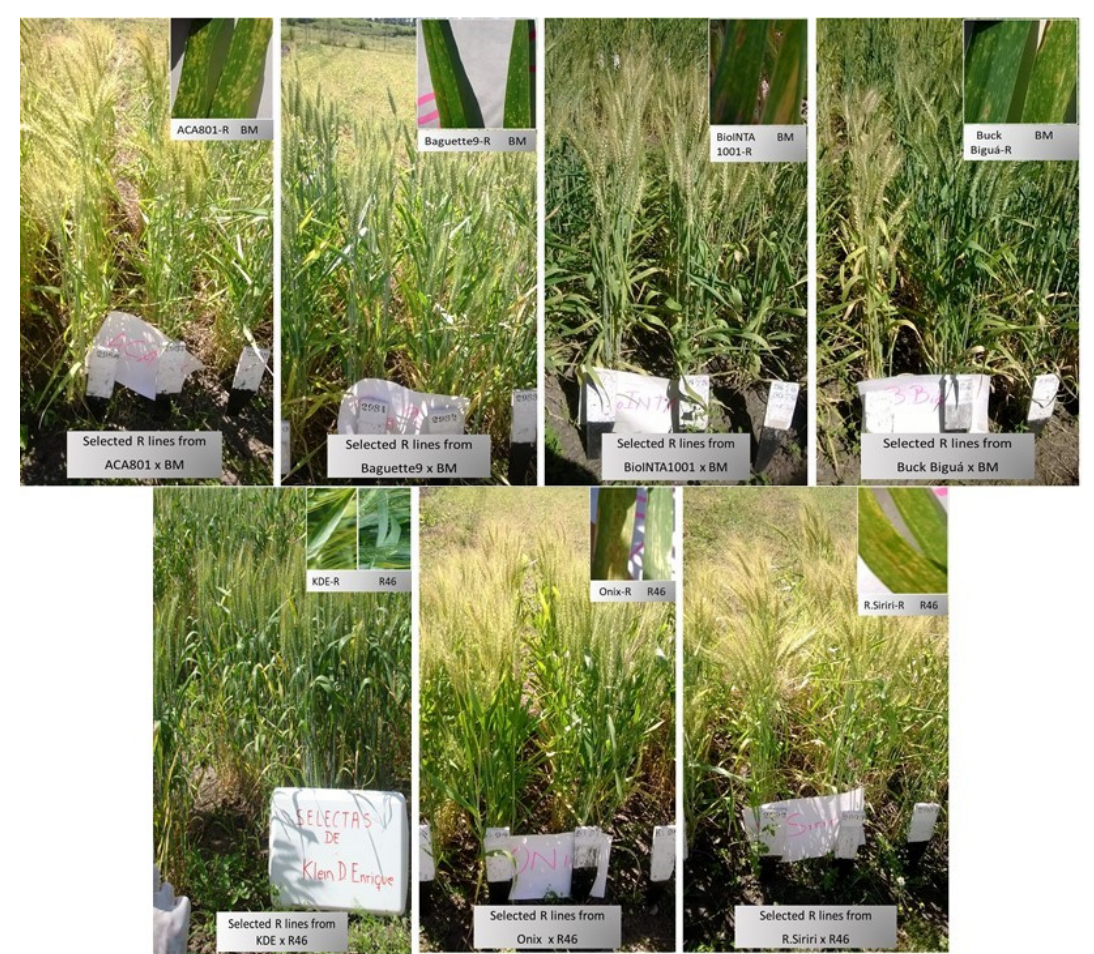
Figure 5. Selected resistant lines at field and detail of infected flag leaves from the introgressed line (left) compared with the resistance donor (right).